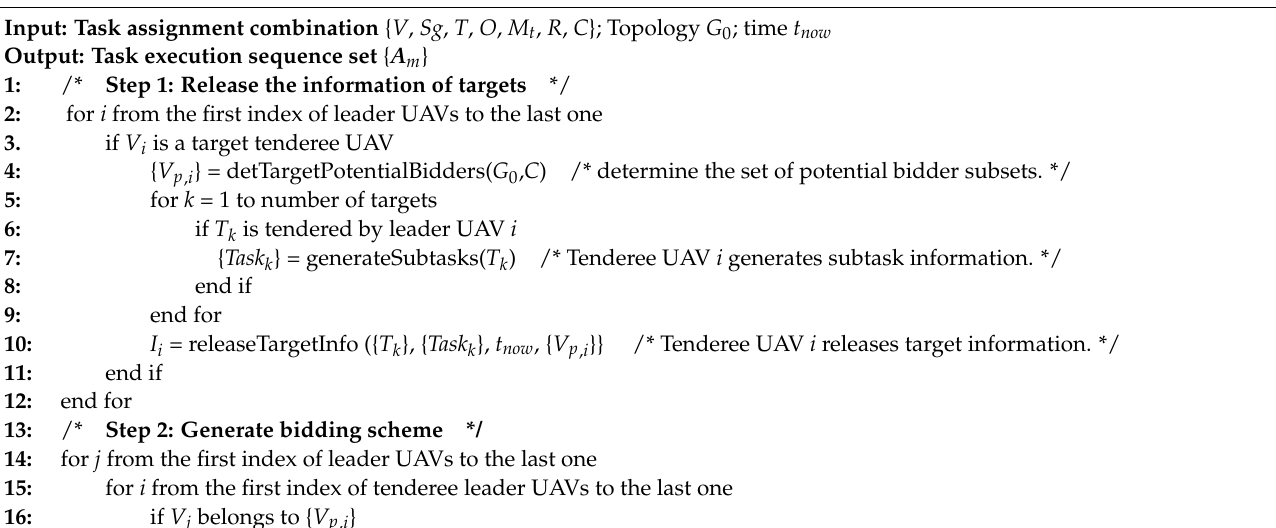
Algorithm 2: The extended Contract Network